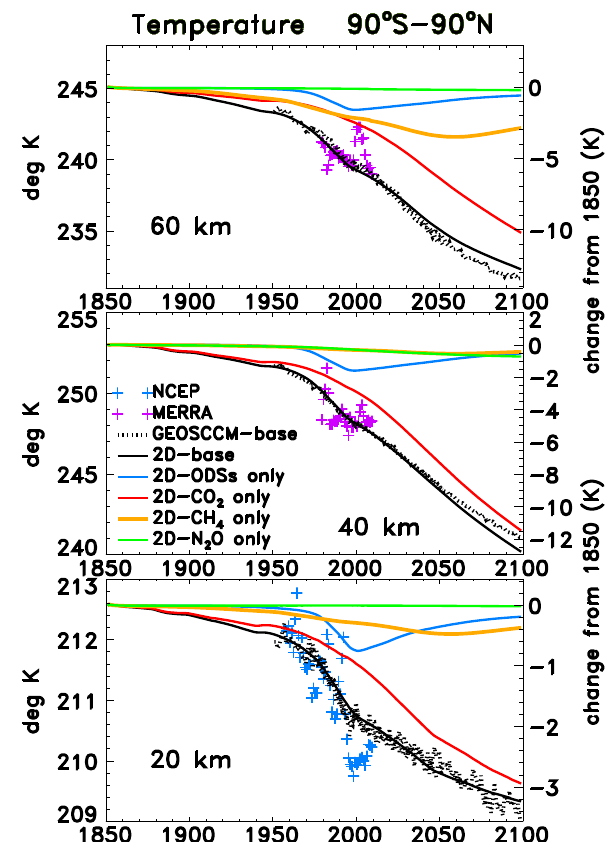
Fig. 10. Global and annually averaged temperature time series for 1850–2100 at 20, 40, and 60 km from the base simulations (all source gases varied time dependently) of the GEOSCCM (black dotted lines) and 2-D model (black solid lines). Also shown are 2-D simulations in which only certain source gases are varied time dependently as follows: ODSs only (blue solid); CO 2 only (red solid); CH 4 only (orange solid); and N 2 O only (green solid), with the other source gases fixed at 1850 levels. The right hand axes show the changes relative to 1850. The observations are from the NCEP reanalysis and reanalysis-2 data at 20 km for 1958–2009 (blue “ + ”), and the new NASA Modern Era Retrospective-analysis for Research and Applications (MERRA) meteorological analyses for 1979–2009 at 40 and 60 km (purple “ + ”). To account for the systematic differences between the models and data, we have added the following offsets to the models at 20, 40, and 60 km, respectively: 2-D model: 0 K, − 3.4 K, − 1.5 K; GEOSCCM: − 2.7 K, + 1.3 K, − 2 K.